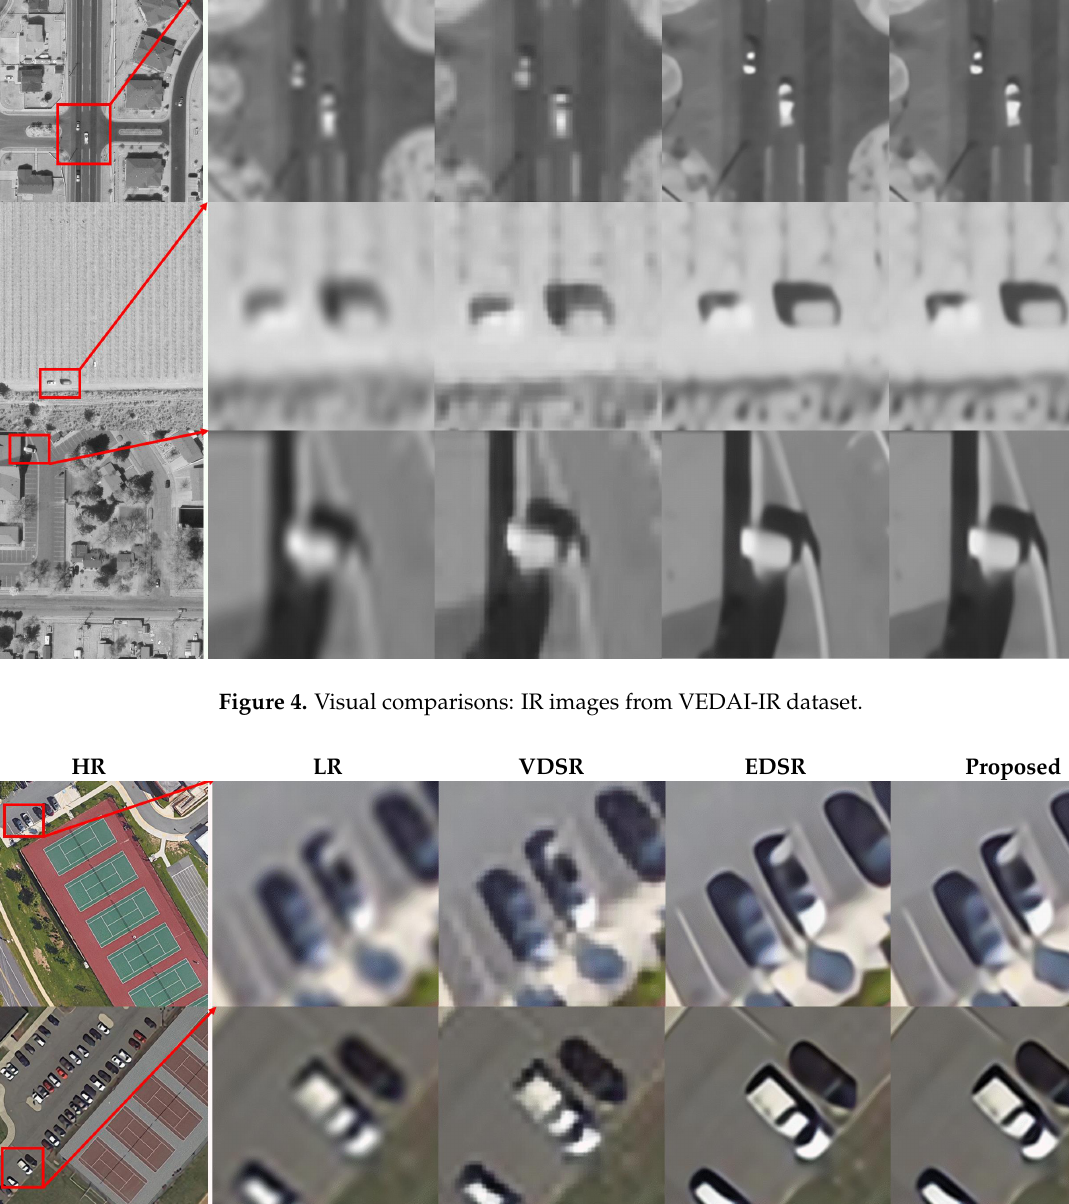
Figure 3. Visual comparisons: VISIBLE images from VEDAI-VISIBLE dataset.